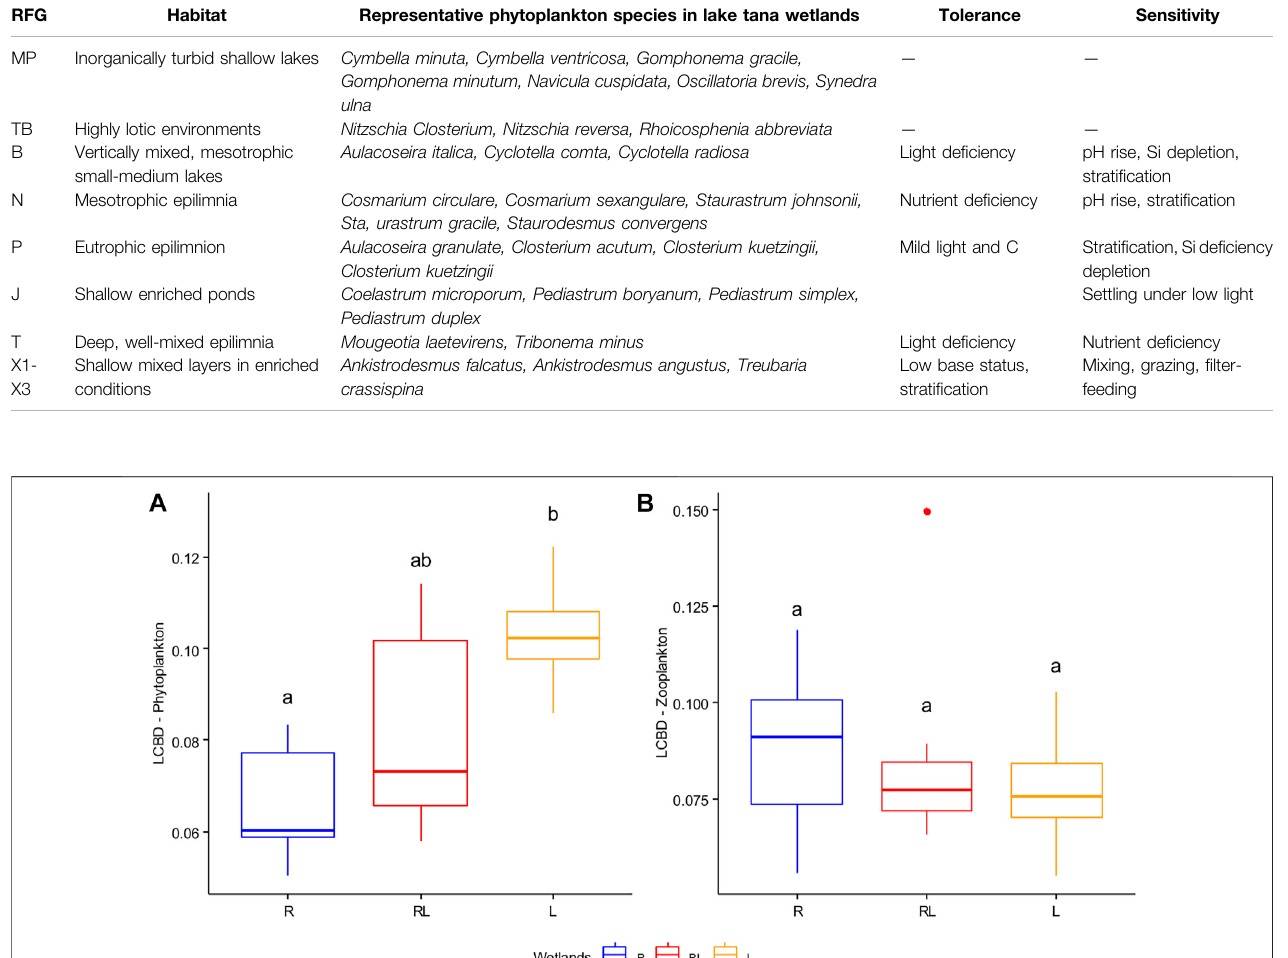
TABLE 2 | Description of the main phytoplankton RFGs (with > 3% contribution) in wetlands of lake Tana and representative taxa (Reynolds, 2002; Padisák et al., 2009).